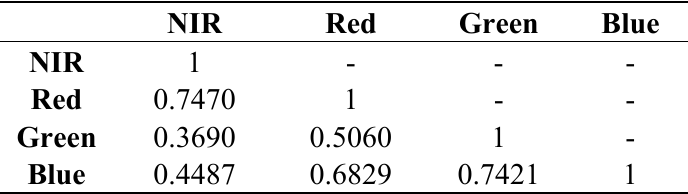
Table 3. Image correlation between different spectra.